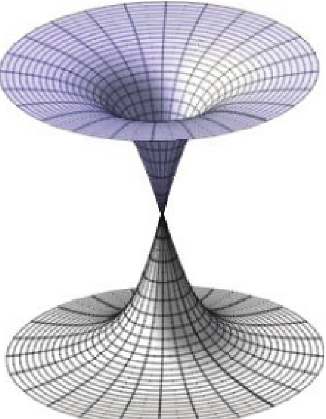
Figure 2: Wormhole. Shown is the embedding diagram for the two 𝐷3 -branes, 𝐷3 1 and 𝐷3 2 , with azimuthal angle suppressed. The domain of the radial coordinate, 𝑟 , is 0 ≤ 𝑟 ≤ 15𝐿 𝑑 , and the range of the embedding coordinate 𝑥 4 is −.45𝐿 𝐷3 ≤ 𝑥 4 ≤ +.45𝐿 𝐷3 .